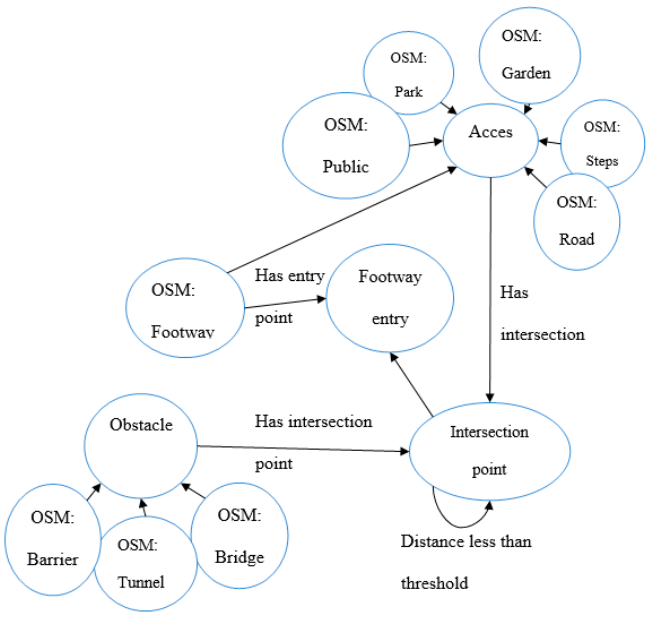
Figure 5. Ontology Web Language (OWL) ontology model to support the retrieval of footway entry points.